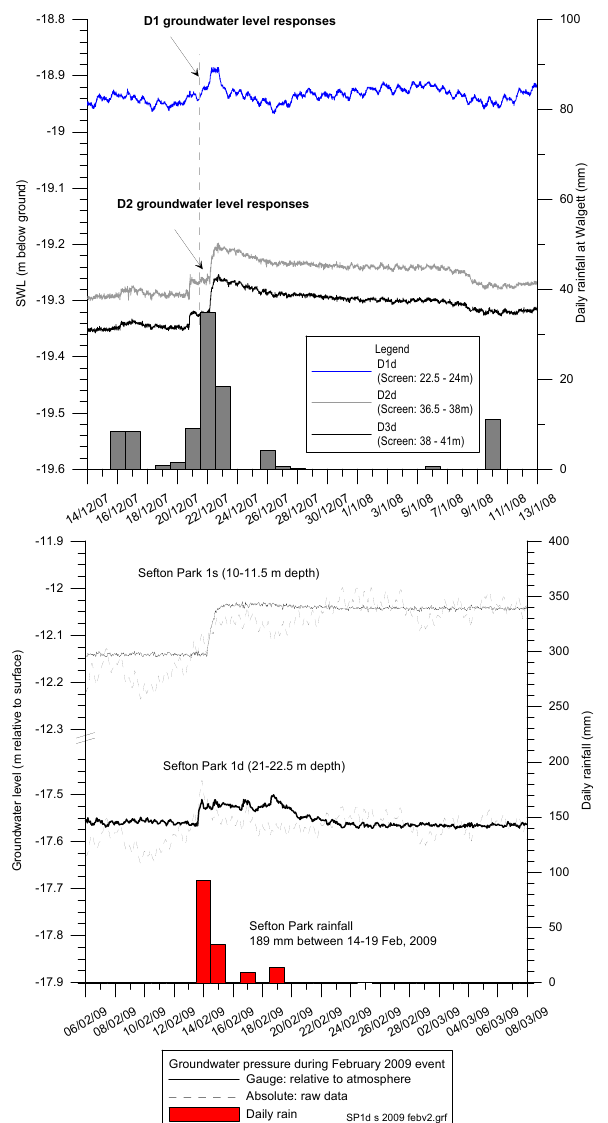
Groundwater level variation at Denham monitoring piezometers for (a) December 2007 rainfall event, with absolute groundwater pressures recorded at 15min intervals and (b) Febru- ary 2009 event at Sefton Park with groundwater absolute and gauge pressures (based on daily rainfall at Sefton Park property).